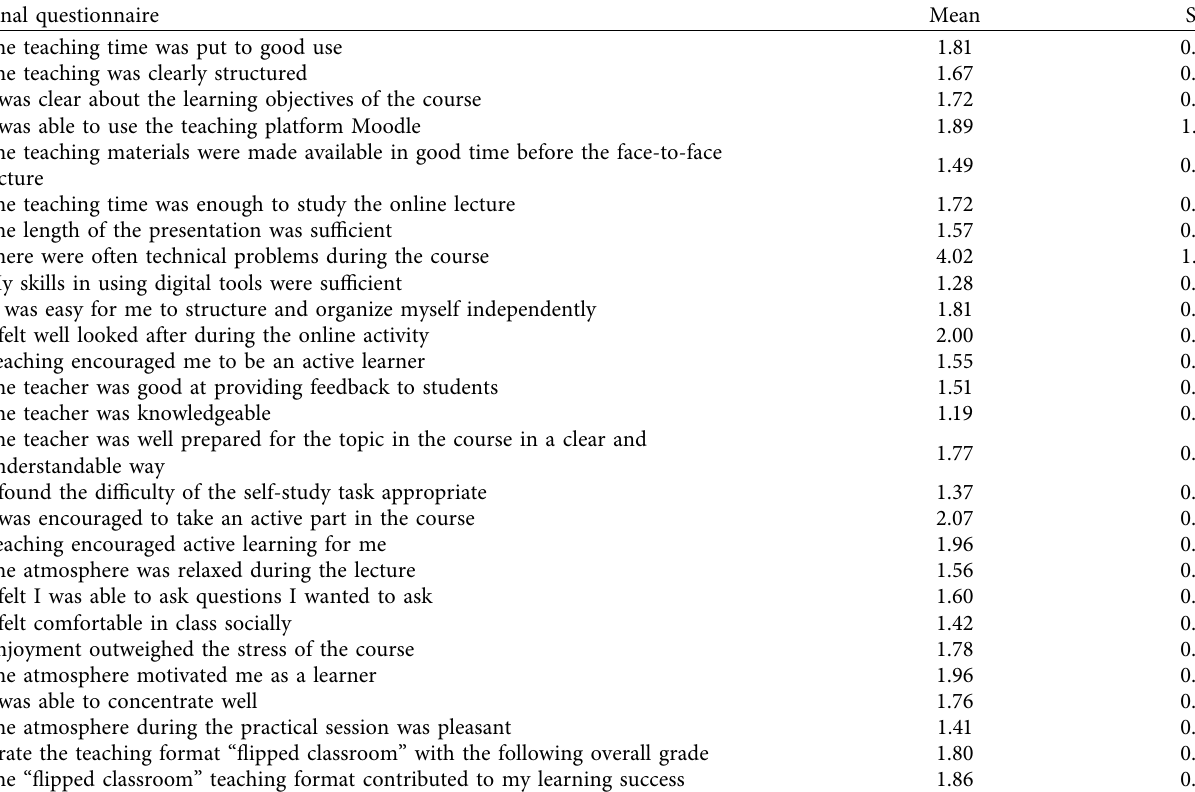
Figure 2: Boxplot of the knowledge level of students for diferent time intervals. T0 � before online education; T2a � before the face-to-face session; T2b � after the face-to-face session; T3 � after the practical session. ∗∗∗ p < 0.001: Friedman and Wilcoxon-signed-rank tests indicate statistically signifcant Table 2: Mean (standard deviation) of the fnal questionnaire about the students’ responses to the use of the fipped classroom (strongly agree � 1–5 � strongly disagree).